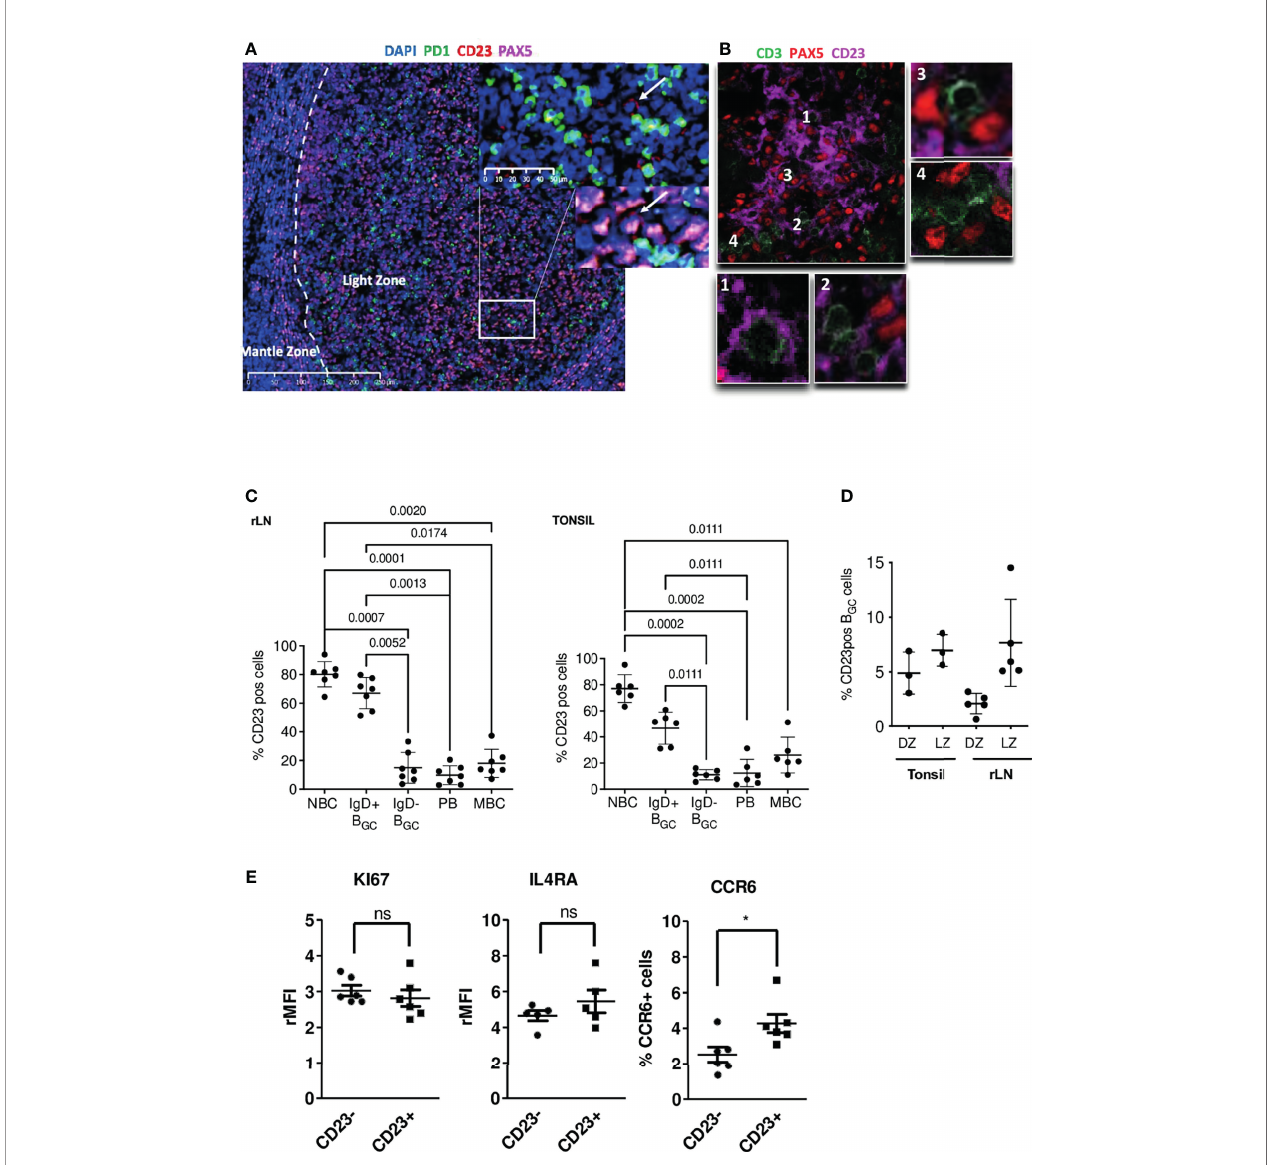
FIGURE 1 | In the GC, CD23 is expressed in the LZ, mainly by FDCs but also by some B cells. (A) Immuno fl uorescence staining of CD23 (red), PAX5 (pink) and PD1 (green) in paraf fi n-embedded tonsil tissues; the white arrow shows a CD23 + B cell located in front of a PD1 + Tfh cell. (B) Immuno fl uorescence staining of CD23 (pink), PAX5 (red) and CD3 (green) on frozen tonsil tissues; the PAX5 staining pattern for B cells does not really match the CD23 marker; panels 1 & 2 show T cells surrounded by CD23 + dendritic extensions, and panels 3 & 4 show T cells in the vicinity of CD23 - B cells. (C) The proportion of CD23-expressing B cells was determined by fl ow cytometry in different B cell populations in tonsils (Right panel) and rLNs (Left panel): CD19 + CD38 - IgD + naïve B cells (NBCs), CD19 + CD38 + IgD + & IgD - B GC -cells, CD19 + CD38 ++ IgD - plasmablasts (PBs), and CD19 + CD38 - IgD - CD27 + memory B cells (MBCs) (one-way Anova & Kruskal-Wallis multiple comparisons test). (D) The proportion of CD23-positive cells in CXCR4 hi CD83 lo DZ B GC -cells and CXCR4 lo CD83 hi LZ B GC -cells in tonsils and rLNs. (E) Flow cytometry analysis of KI67, IL4RA and CCR6 in tonsil CD23 + and CD23 - LZ B GC -cells. Results are expressed as the relative mean fl uorescence intensity (rMFI) or the percentage of positive cells (* P ≤ .05; "ns" for non signi fi cant; Mann-Whitney